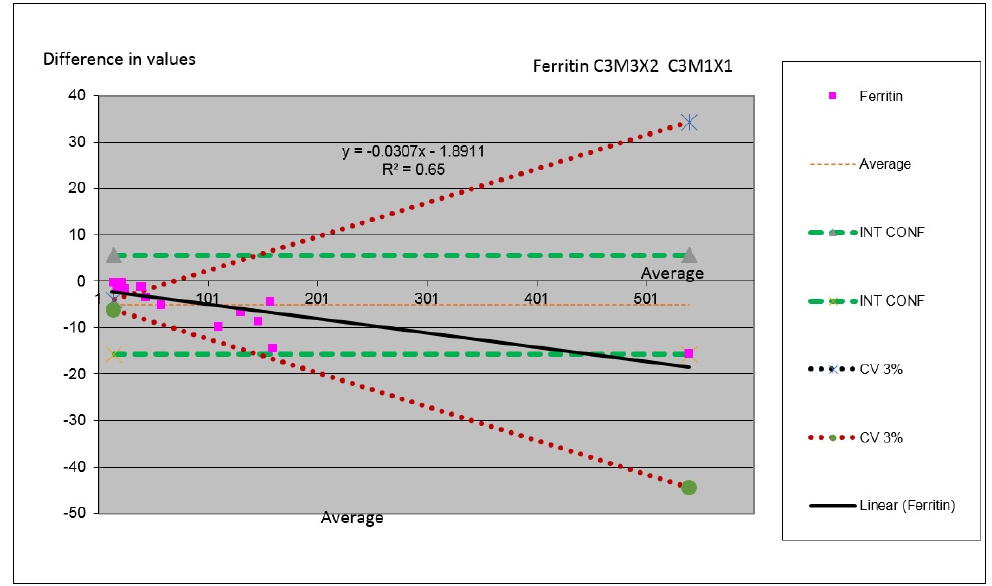
Figure 10. Comparison between modules for the Ferritin parameter in which we have compared the results obtained by the measurements performed in the two machines (Analyzer C3 substituted by C2 in which the Module 3 is substituted by the Module M3 and the Channel X2 is substituted by the Channel X2).